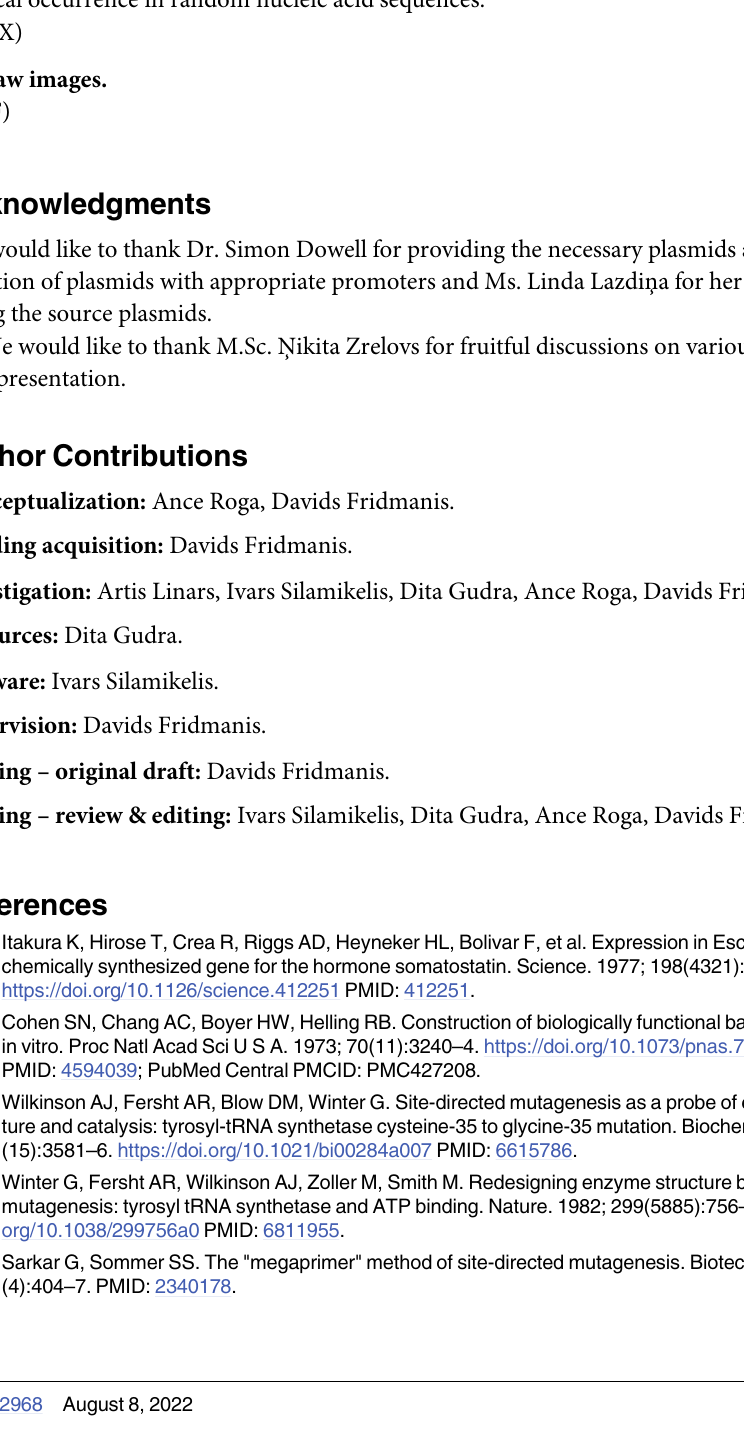
represent the randomized region, template DNA, synthesized chain, and DNA synthesis, respectively. S1 Table. List of peptide variants that were identified and the average frequency of a spe- cific aa occurrence at every position. Sheet 1: list of variants that were identified during each experiment, number of reads that encode each peptide, and their relative abundance within each dataset and CPO. Variants with CPOs < 1 are shaded in red. Sheet 2: average frequency of a specific aa occurrence at every position during each experiment and comparison to their the- oretical occurrence in random nucleic acid